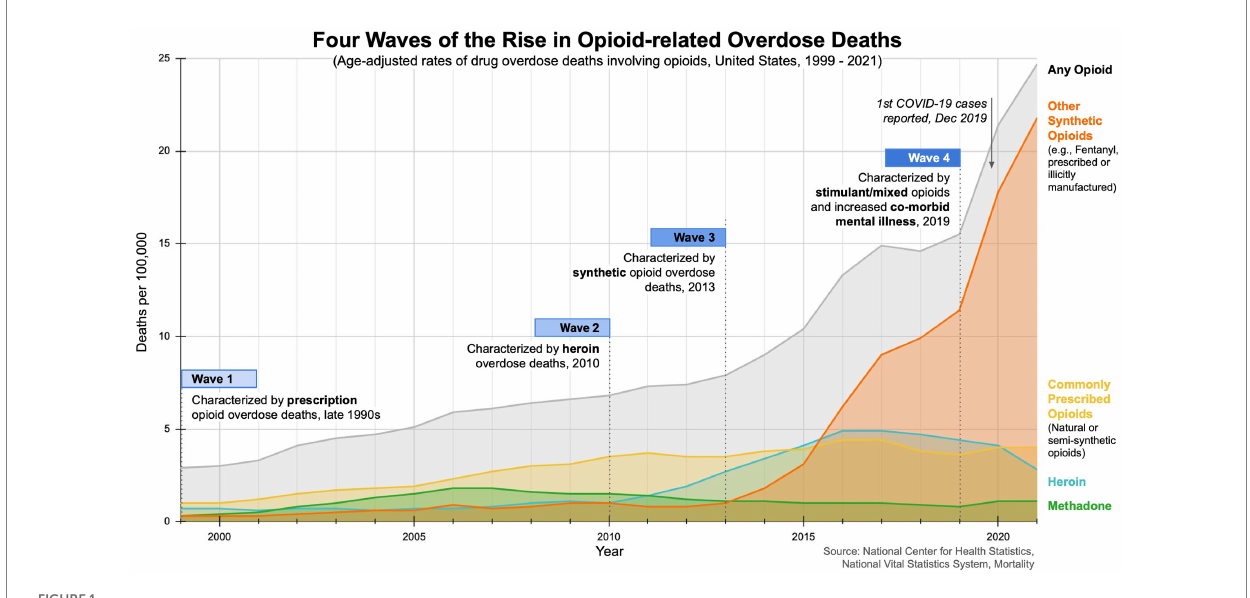
FIGURE 1 Four waves of the rise in opioid-related overdose